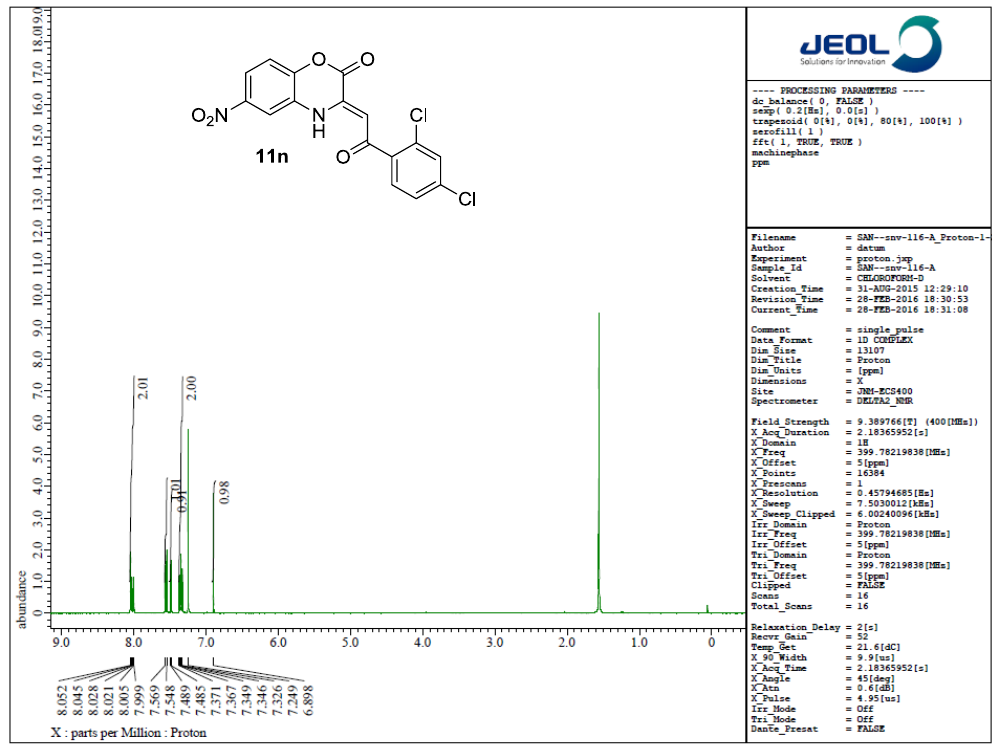
Figure 27. 1 H NMR Spectra of Compound 11n.